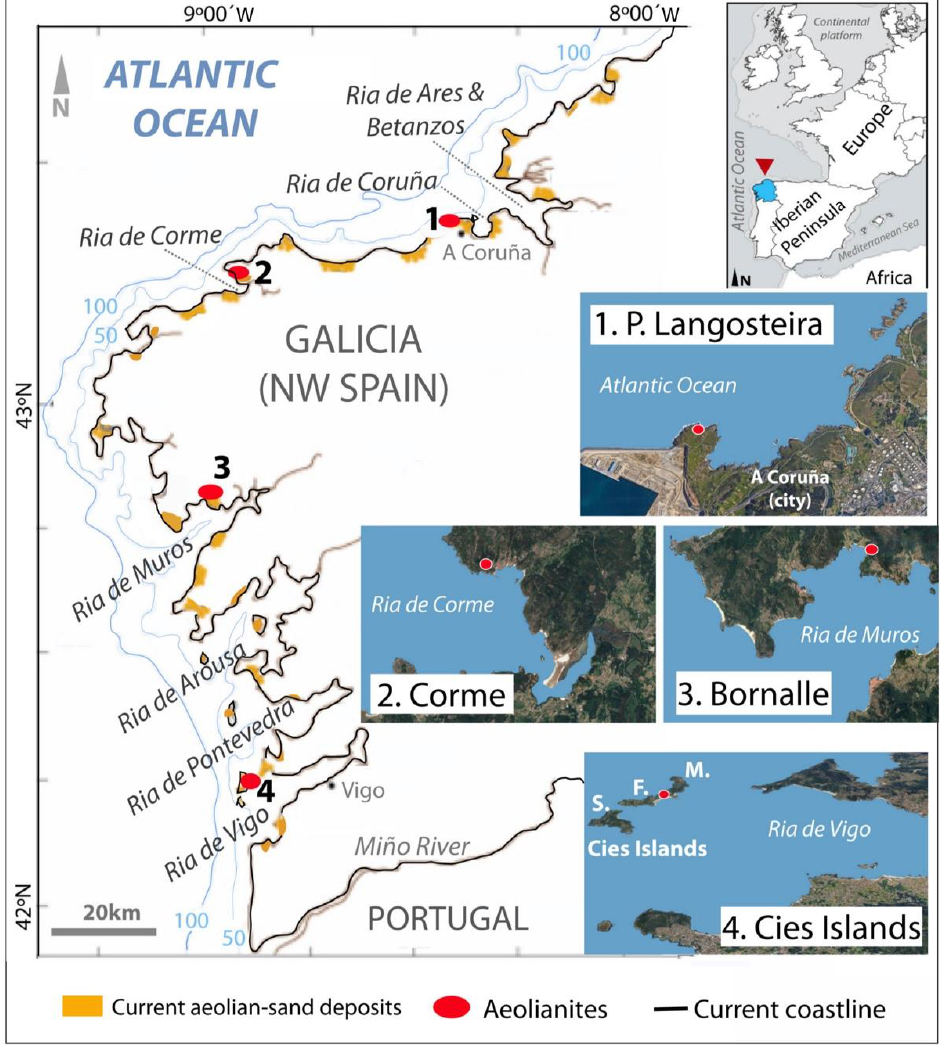
Figure 1. Location map. Current aeolian sand dunes (yellow areas) on the Atlantic coast of Galicia (NW Spain) and the location of the old climbing dunes (red dots) dated in this paper. (M) Monteagudo, (F) Faro and (S) San Martiño of the Cíes Islands. The 100 m and 50 m isobaths are also shown.